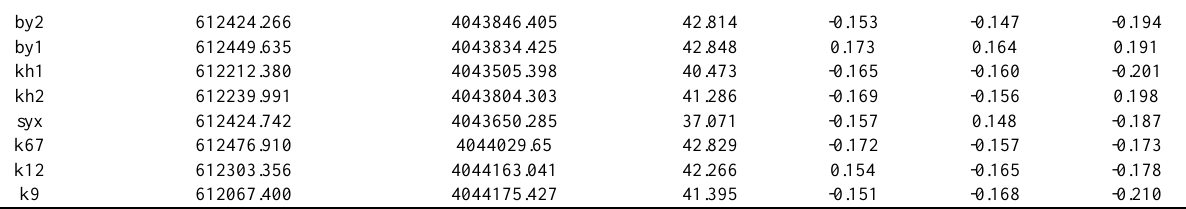
Table 8. Scheme Ⅲ experimental data